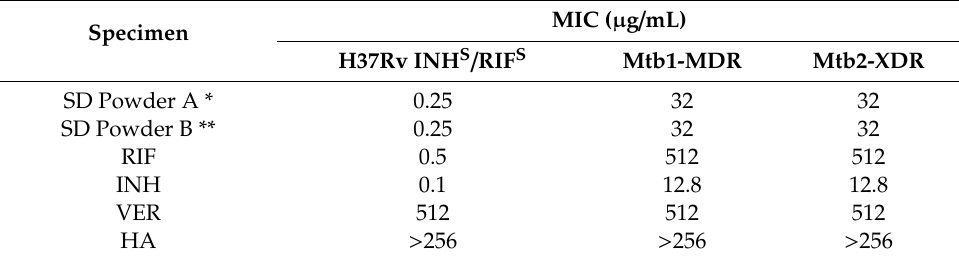
Table 4. Minimum inhibitory concentrations (MIC) of the dried powder (A), a spray dried powder without verapamil (B) and the components of the formulation taken individually (rifampicin, RIF; isoniazid, INH; verapamil, VER; low molecular weight sodium hyaluronate, HA). The assays were performed at least in triplicate (biological